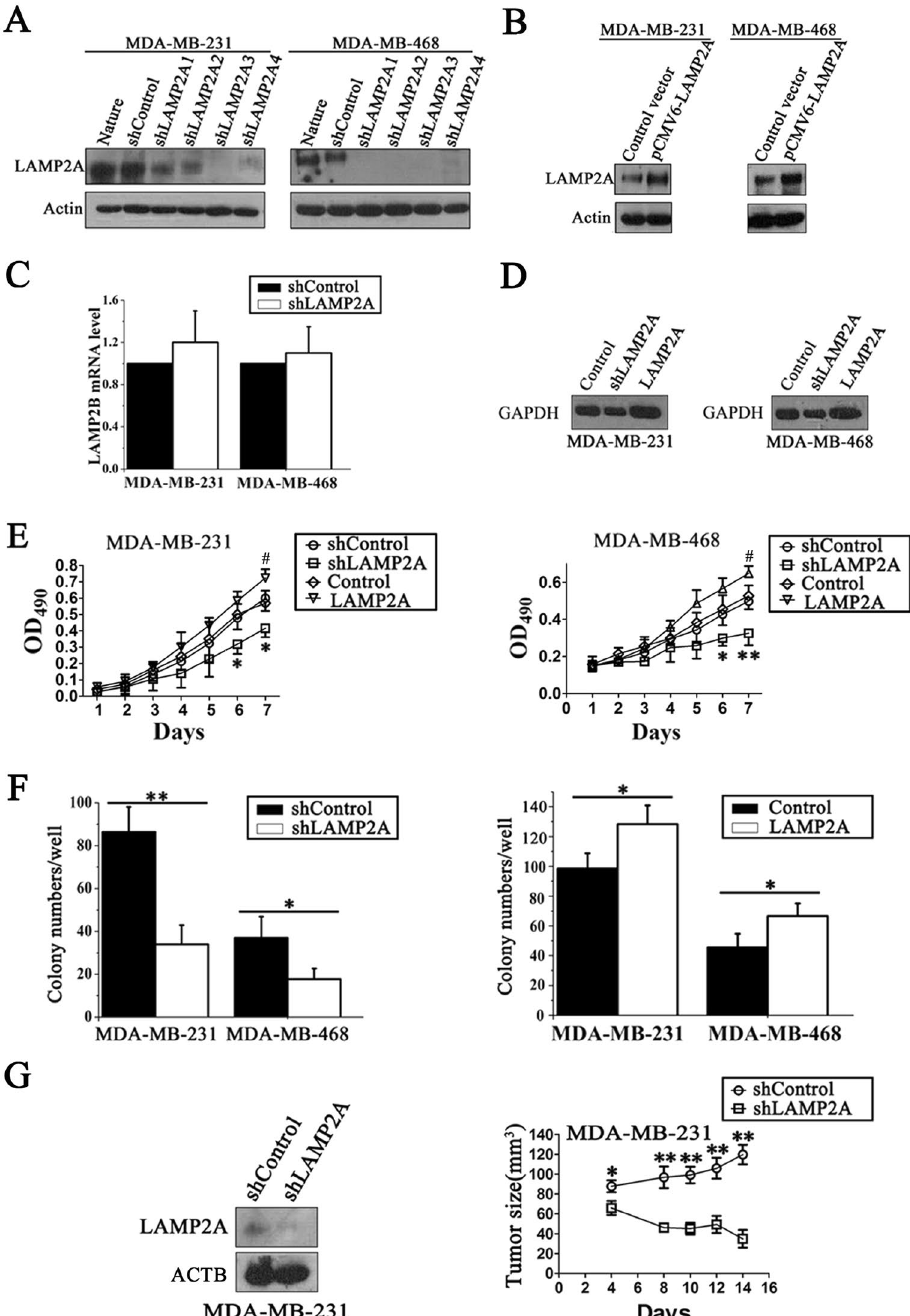
Figure 2. CMA promotes breast cancer cell growth and survival. ( A ) The stable inhibitory efficiency of shRNAs against LAMP2A in MDA-MB-231 and MDA-MB-468 cells was detected. ( B ) Western blotting detected LAMP2A overexpression by transient transfection in two breast cancer cell lines. ( C ) The LAMP2B mRNA level was determined in MDA-MB-231 and MDA-MB-468 cells by qRT-PCR. ( D ) Purified GAPDH protein was incubated with intact lysosomes isolated from the stable LAMP2A knockdown and overexpression cells and then harvested, fractionated and immunoblotted with a GAPDH antibody. ( E ) The cell growth rate was determined by an MTT assay at indicated timepoints in MDA-MB-231 cells and MDA-MB-468 cells. ( F ) A colony formation assay was performed to detect the proliferative capability of the breast cancer cells. The cells were seeded onto 6-well plates and allowed to form colonies for two weeks. All values are expressed as the mean ± SD of three different experiments; * P < 0.05 and ** P < 0.01, shLAMP2A versus shControl at the same timepoint; # P < 0.05, LAMP2A overexpression group versus the control group at the same timepoint. ( G ) 1 × 10 7 shLAMP2A or shControl MDA-MB-231 cells were subcutaneously injected into nude mice. The LAMP2A protein levels in the tumors at the time of resection were determined by immunoblots (left), and the size of the tumors was monitored by the standard formula length × width × width × 0.5 (right) (n = 5; * P < 0.05, shLAMP2A or